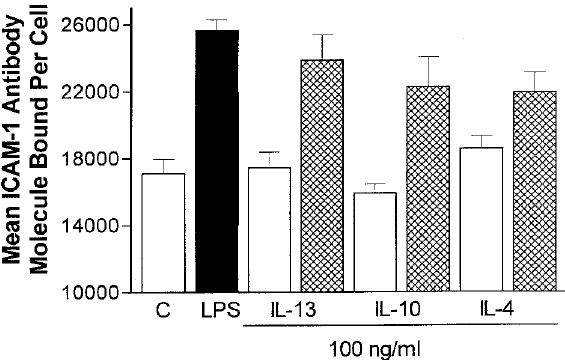
FIG. 4. Effect of interleukin-13 (IL-13), interleukin-10 (IL-10) or interleukin-4 (IL-4) on the increase in the expression of ICAM- 1 on the cell plasma membrane of J774.2 macrophages caused by endotoxin. J774.2 cells were incubated in the absence (open columns) or presence (hatched columns) of LPS (1mg/ml) with IL-13, IL-10 or IL-4 (all 100ng/ml) for 4h. At 4h after LPS ICAM-1 expression was monitored by FACS analysis. Data are expressed as mean±S.E.M. from triplicate determinations (wells) from three separate experimental days ( n =9). * P <0.05 represents significant difference when compared to LPS controls (solid